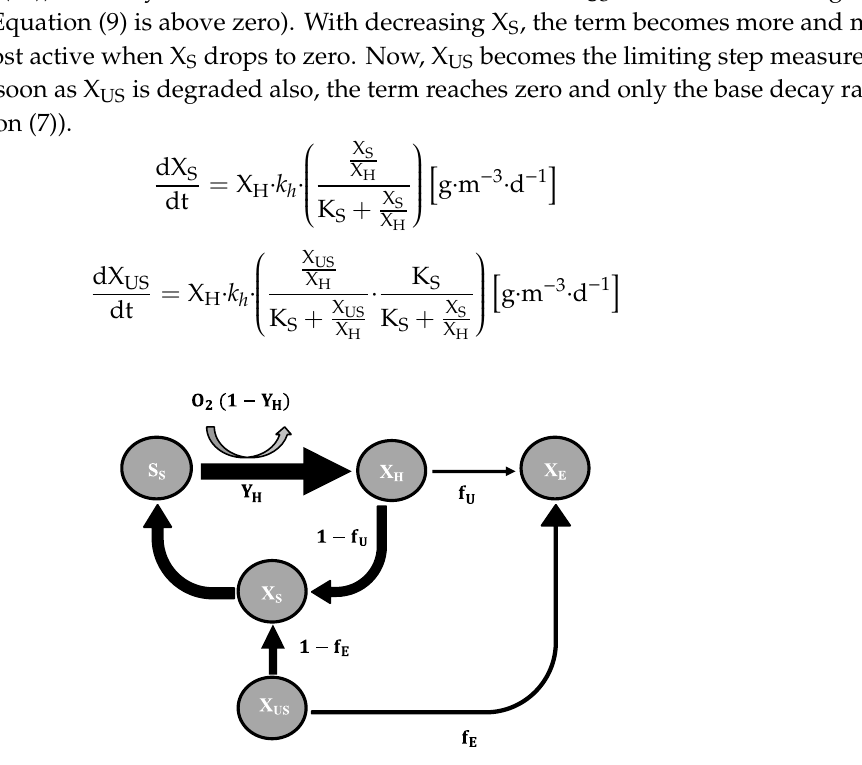
Figure 11. Extending of the death-regeneration model.